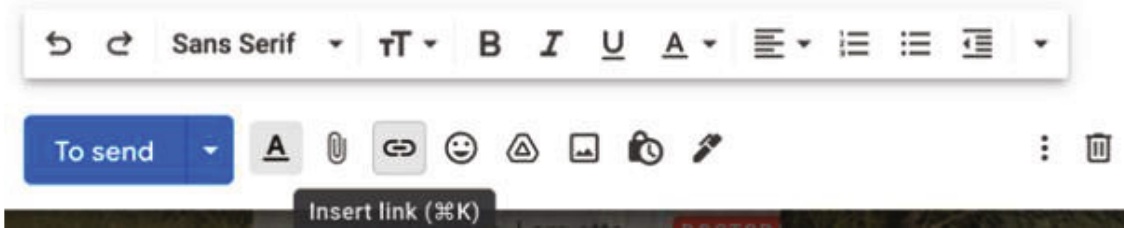
Figure 10: Example of the shortcut tooltip presented in Google